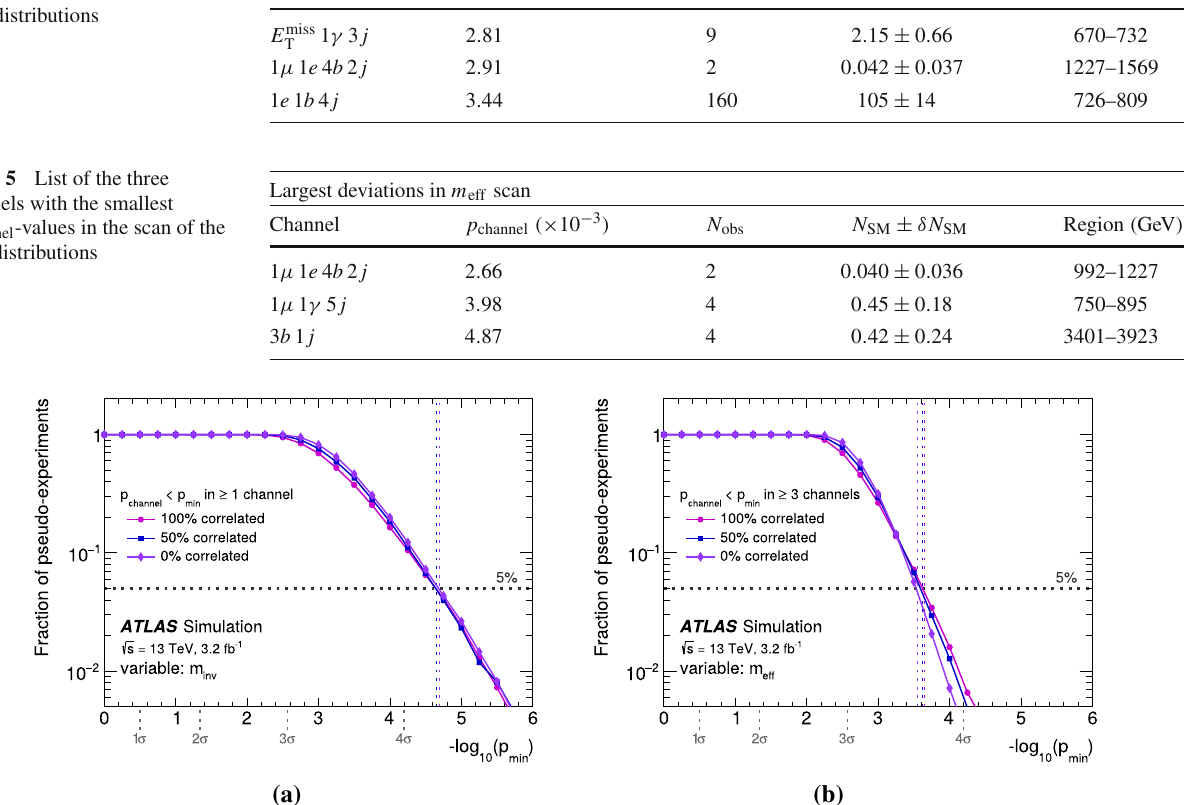
Table 4 List of the three channels with the smallest p channel -values in the scan of the m